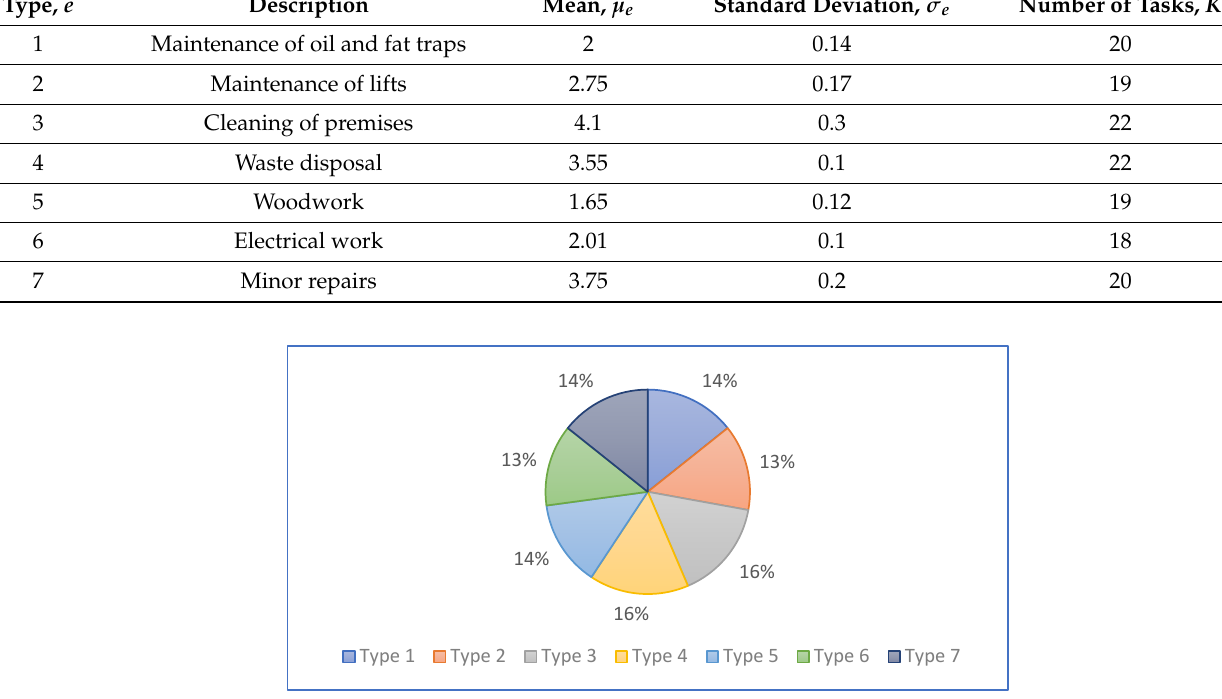
Table 4. Services offered and normal distribution parameters for testing durations.